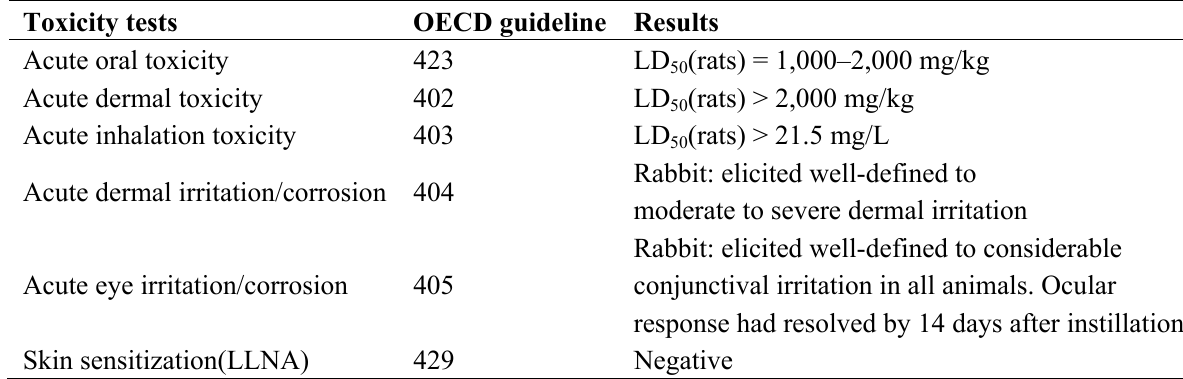
Table 1. The acute toxicity studies of